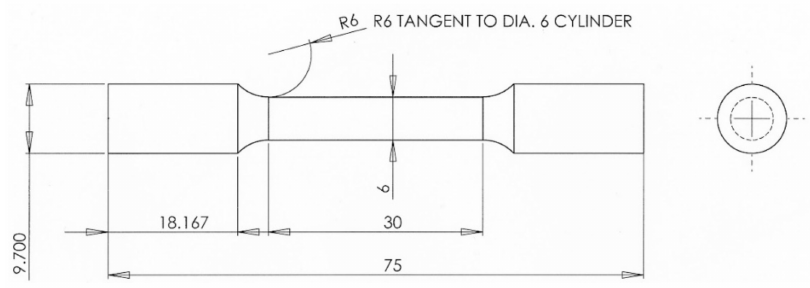
Figure 2. Tensile test specimen geometry. All dimensions are in